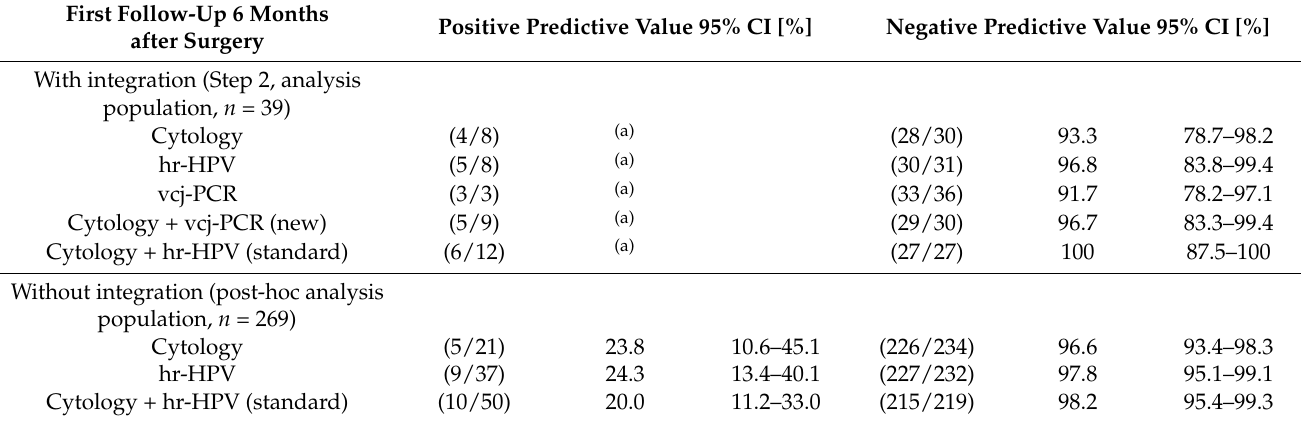
Table 3. Positive and negative predictive values of first follow-up tests in patients with and without HPV16/18 DNA integration to predict recurrent pre-cancer at visit or